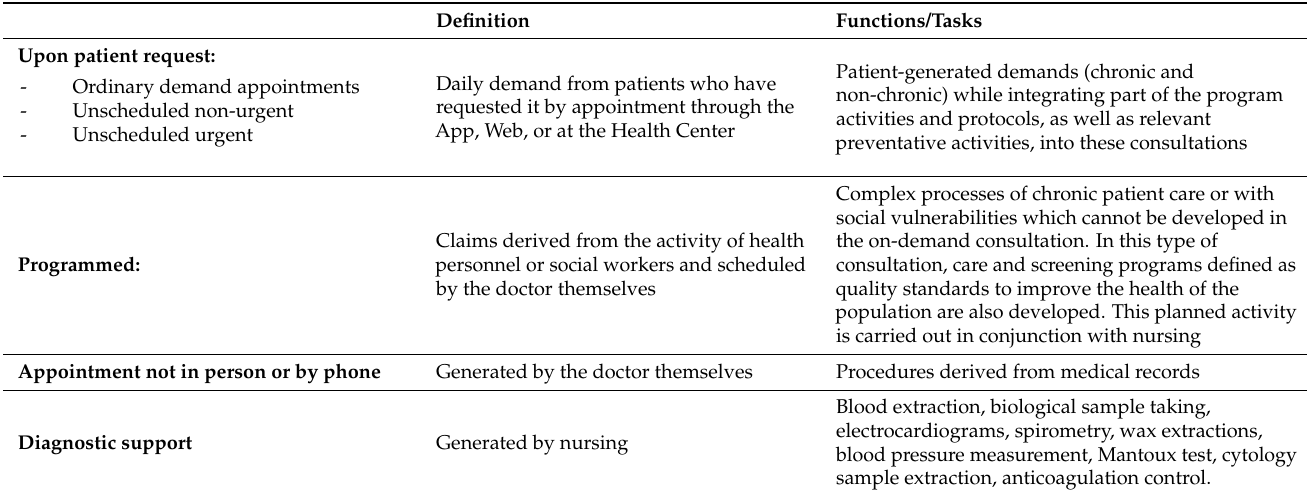
Table 4. Direct care